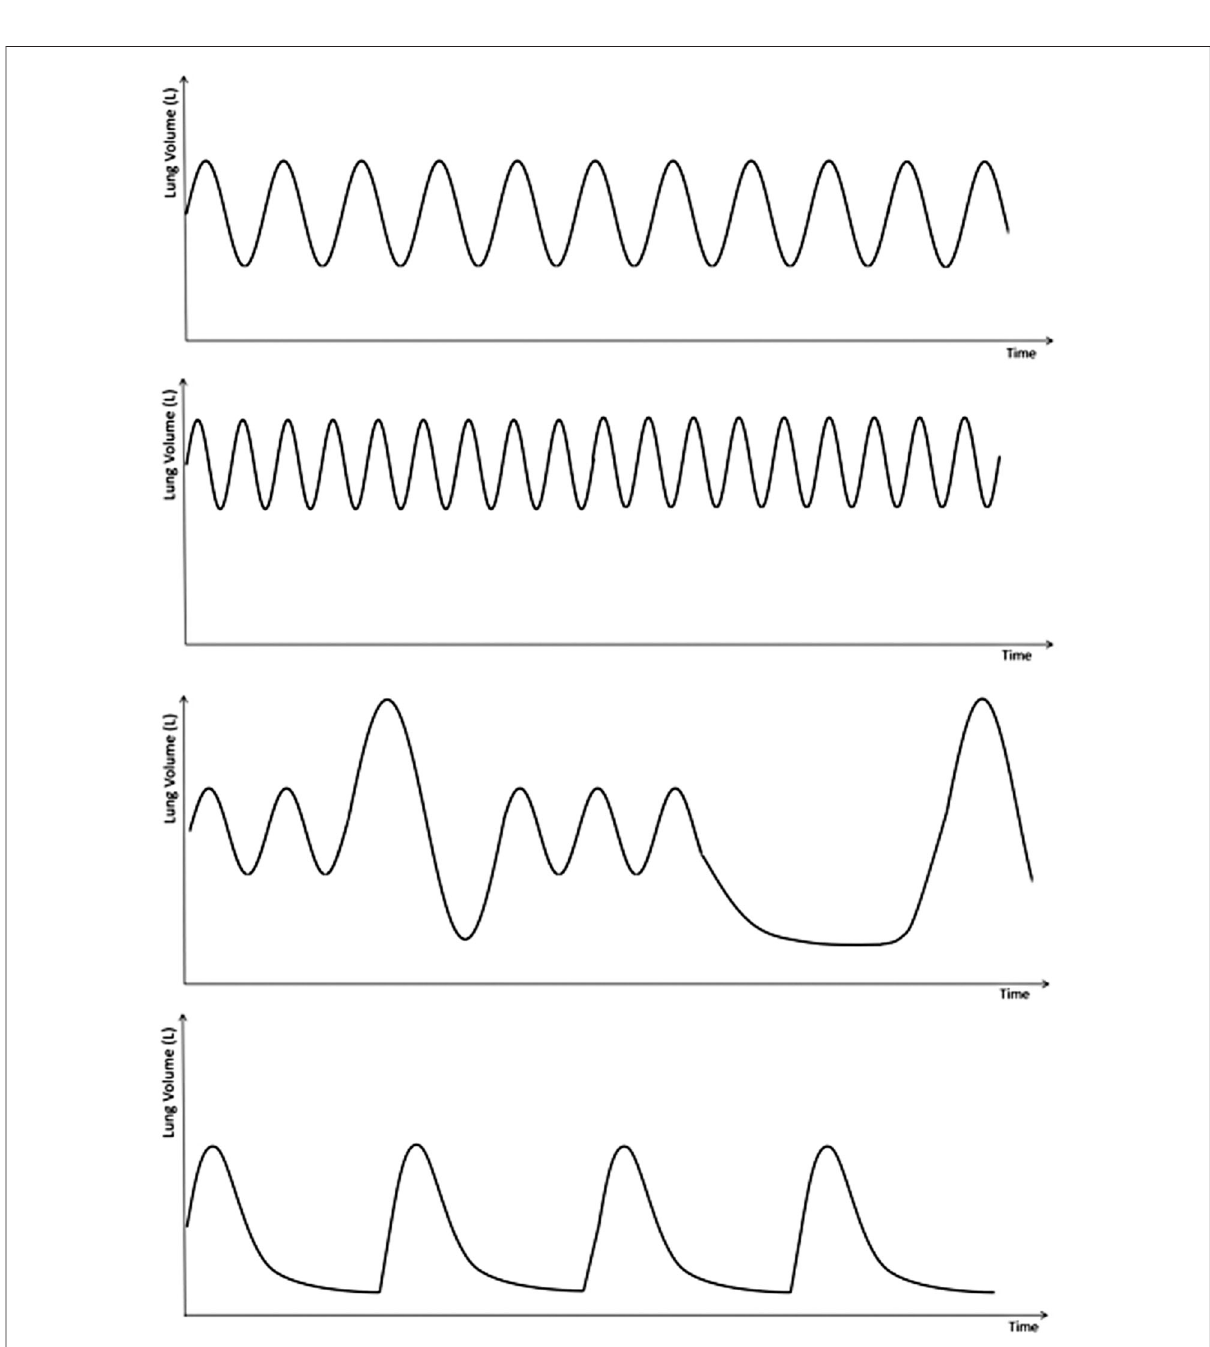
FIGURE 4 Representation of pneumotach readings, demonstrating: ( A ) normal tidal breathing; demonstrates a Normal breathing rate and rhythm. Note the placement of the breaths relative to the y axis — this demonstrates normal residual volume. (B) Hyperventilation: short, shallow, rapid breaths. Note the larger residual volume ( C ) periodic deep sighing with random breath hold: this graph shows normal tidal breathing interspersed with random deep sighs. Sighs are described as breaths with volumes 3 times the normal tidal volume. This graph also shows a random breath hold on expiration prior to a deep sigh. ( D ) Forced abdominal exhalation. Although not well described in the literature, this DB pattern results from excessive abdominal muscle use with longer expiratory phase and lower residual